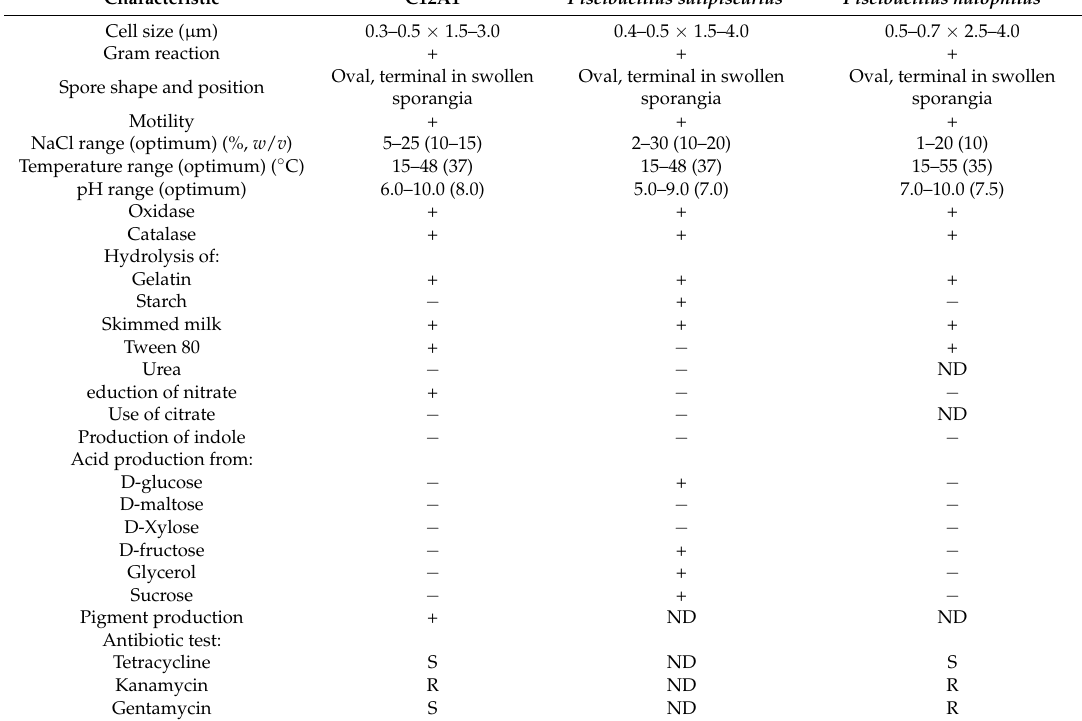
Table 1. Characteristics of the strain C12A1 and its differences with other phylogenetically related species Piscibacillus salipiscarius and Piscibacillus